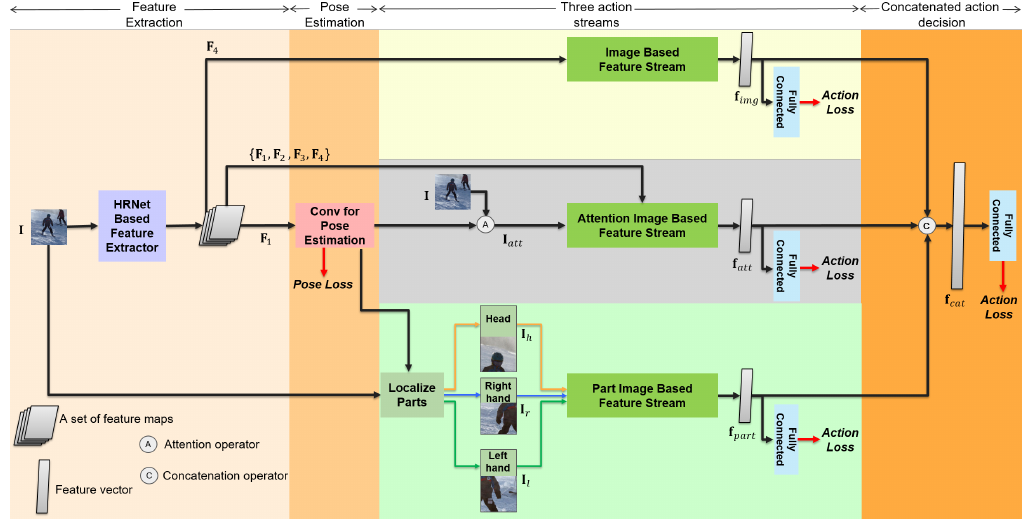
Figure 1. Proposed method. The proposed method is one end-to-end trainable convolutional neural network. The HRNet-based feature extractor is shared between pose estimation and action recognition task in a multitasking